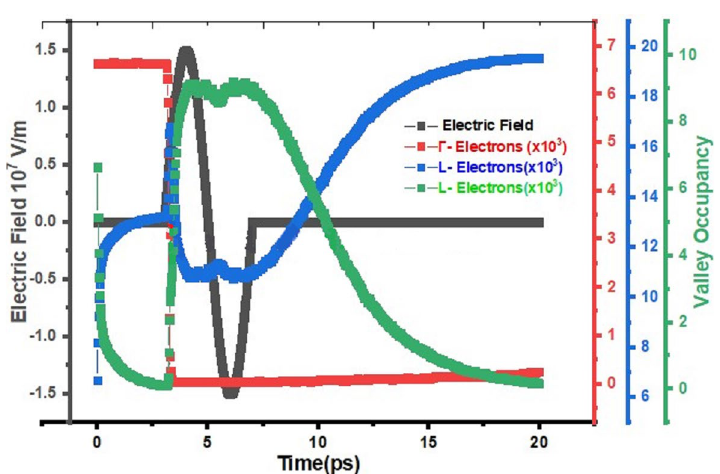
Figure 4. Variation in THz field Intensity with transition in number of electrons of Γ, L and X valley due to interaction of THz field at 0.25 THz frequency with respect to